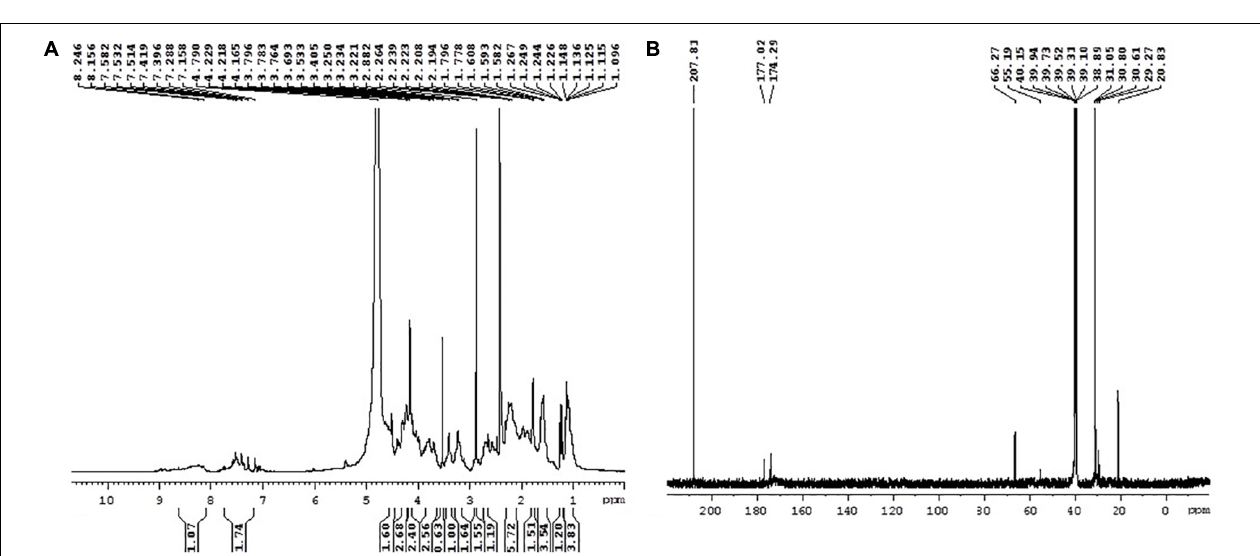
FIGURE 4 | Fourier transform infrared (FTIR) spectra of the column-purified active fraction of the biosurfactant produced by MSI 54.